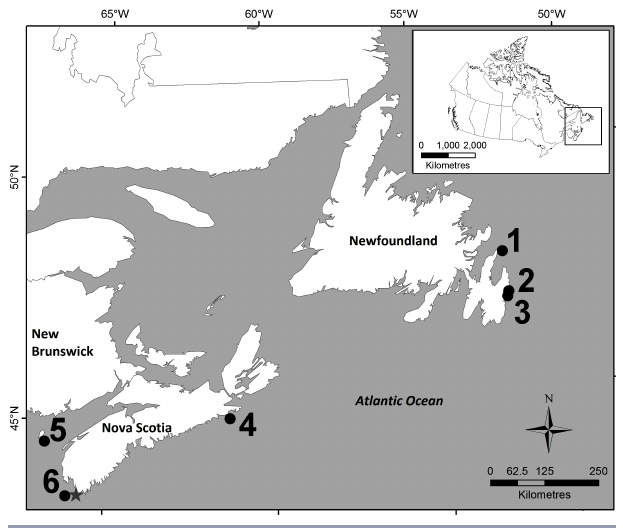
Fig. 1 . Location of the study site, Bon Portage Island, Nova Scotia, Canada (star) and other nearby Leach’s Storm-petrel (Oceanodroma leucorhoa) colonies mentioned in text. (1) Baccalieu Island, Newfoundland; (2) Gull Island, Newfoundland; (3) Great Island, Newfoundland; (4) Country Island, Nova Scotia; (5) Kent Island, New Brunswick; (6) Seal Island, Nova